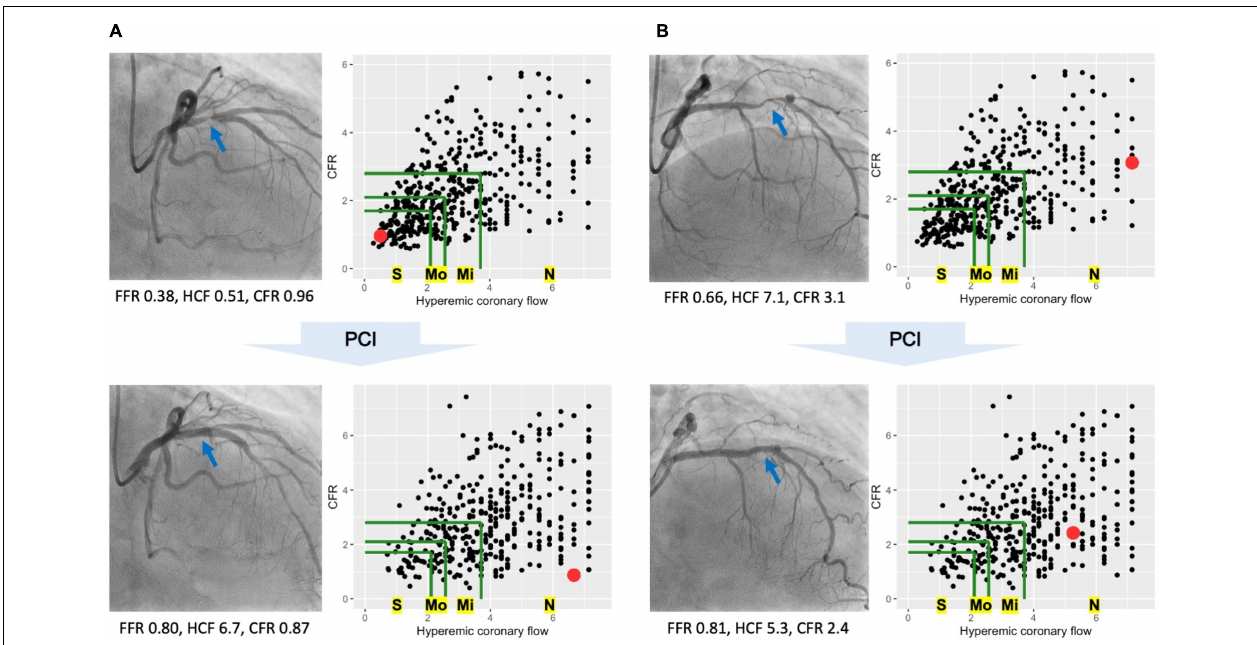
FIGURE 1 | Coronary flow capacity (CFC) changes in two representative cases. Two representative cases showing distinct CFC changes following percutaneous coronary intervention (PCI). In each cine image, blue arrows indicate the culprit lesions in the left anterior descending arteries. Each scatter plot shows CFC map, where each dot representing one vessel is mapped according to the hyperemic coronary flow (hCF, x-axis) and coronary flow reserve (CFR, y-axis). Green lines are the boundaries of CFC categories; the bounded most inner to outer areas are corresponded to severely reduced (S), moderately reduced (Mo), mildly reduced (Mi), and normal CFC (N), respectively. Red dots in the CFC maps represent the cases of each cine image. (A) PCI increased the hCF from 0.51 to 6.7 with a little effect on CFR, leading to the improvement in CFC categories from severely reduced to normal ones. Benefit of PCI would be expected in such cases with greater CFC improvement (i.e., lower risk of target-vessel failure). (B) PCI did not let changes in CFC categories; pre-PCI normal to post-PCI normal CFC. In such cases with no CFC improvement following PCI, the improvement in fractional flow reserve (FFR) might indicate the modification in the epicardial lesions but not the coronary flow restoration, potentially highlighting the limited benefit of PCI. TABLE 1 | Baseline characteristics by pre-revascularization CFC status. Pre-PCI CFC